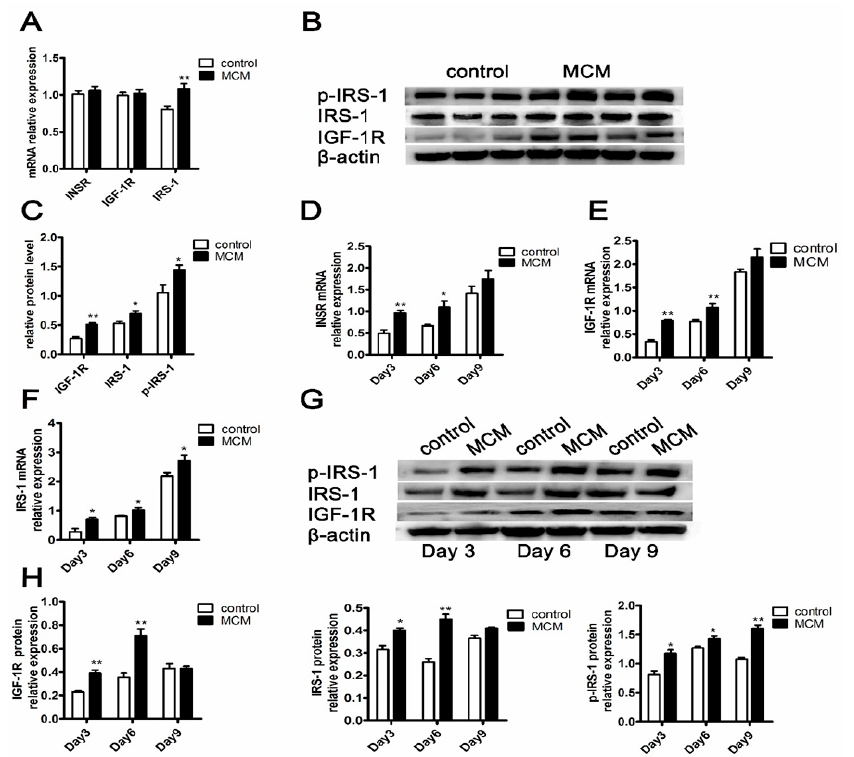
Figure 7. The genes expression patterns in the INSR / IGF-1R - IRS-1 signaling. The mRNA expression of INSR , IGF-1R and IRS-1 with MCM treatment at the pre-differentiation stage of adipocyte differentiation for three days ( A ) ( n = 4); The protein abundance of IGF-1R , IRS-1 , and p-IRS-1 with MCM treatment at pre-differentiation stage for three days ( B ) and protein quantified was shown ( C ) ( n = 3 for control, n = 4 for treatment); The mRNA expression of INSR ( D ) ( n = 6), IGF-1R (( E ) n = 6), and IRS-1 (( F ) n = 6) with MCM treatment for different durations; The protein abundance of IGF-1R , IRS-1 , and p-IRS-1 with MCM treatment during different differentiation durations ( G ) and protein quantified was shown (( H ) n = 3); The mRNA expression differences were normalized to RPLP0 mRNA level. The β -actin bands served as an internal control for protein loading, p-IRS-1 (Try) expression was normalized to IRS-1 expression. * p < 0.05, ** p < 0.01.